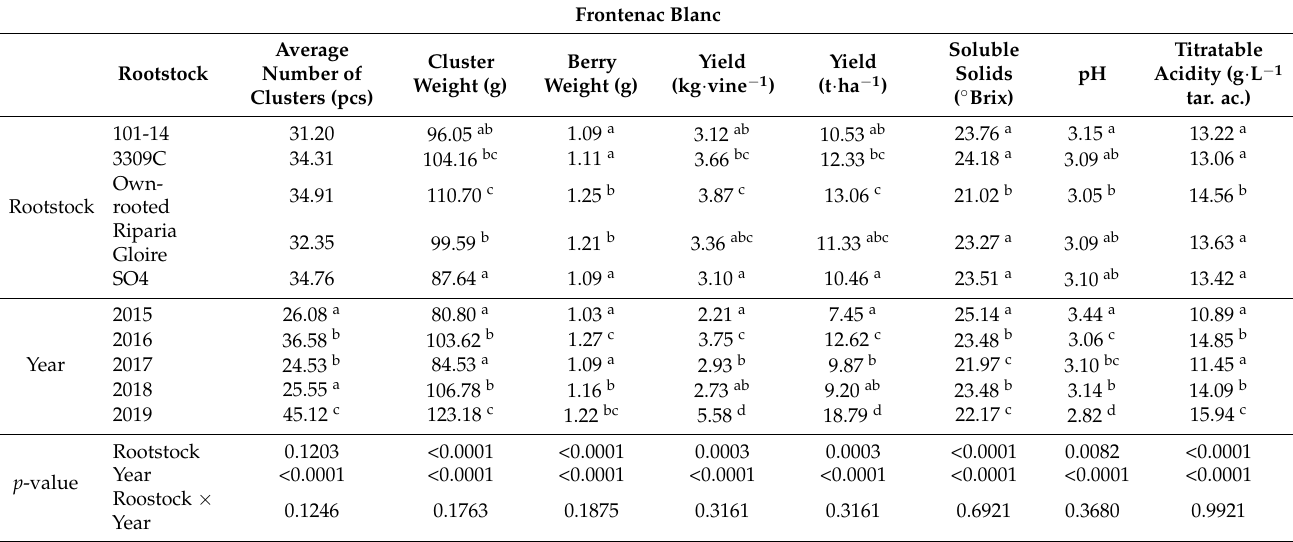
Table 8. Effect of rootstock on yield quantity and fruit composition of grapevine ‘Frontenac blanc’. Frontenac